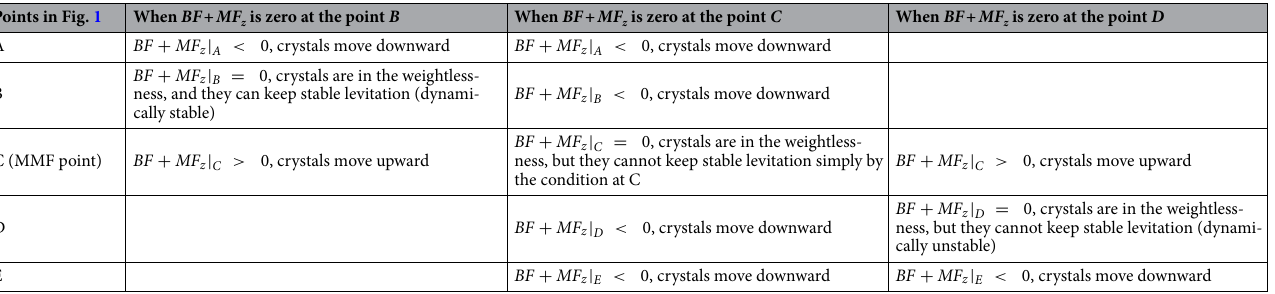
Table 1. The summary of the force balance between the buoyancy force ( BF ) and vertical component of the magnetic force ( MF z ). We assume the vertically upward force is positive and the point C is the MMF point. So the relationships of BF < 0, MF z > 0, MF z | A < MF z | B < MF z | C , and MF z | E < MF z | D < MF z | C are